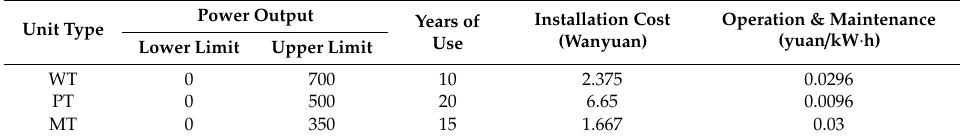
Table A7. Unit parameters.